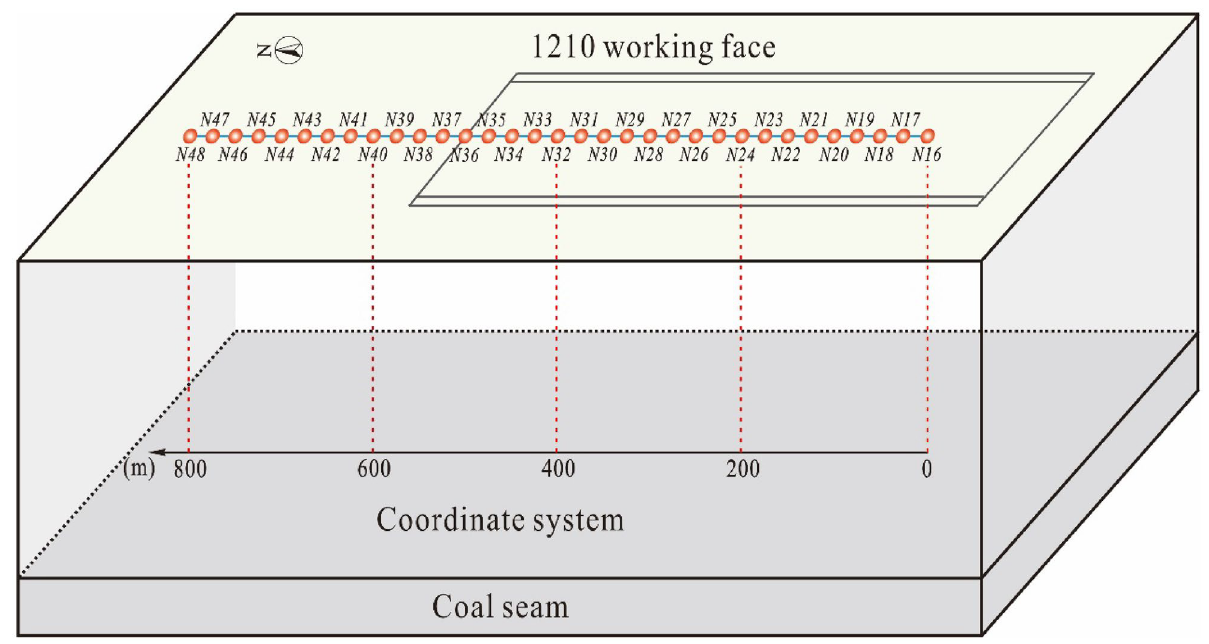
Figure 5. Comparison diagram of observation station of 1210 working face of Mumba Coal Mine (The letter N represents north–south